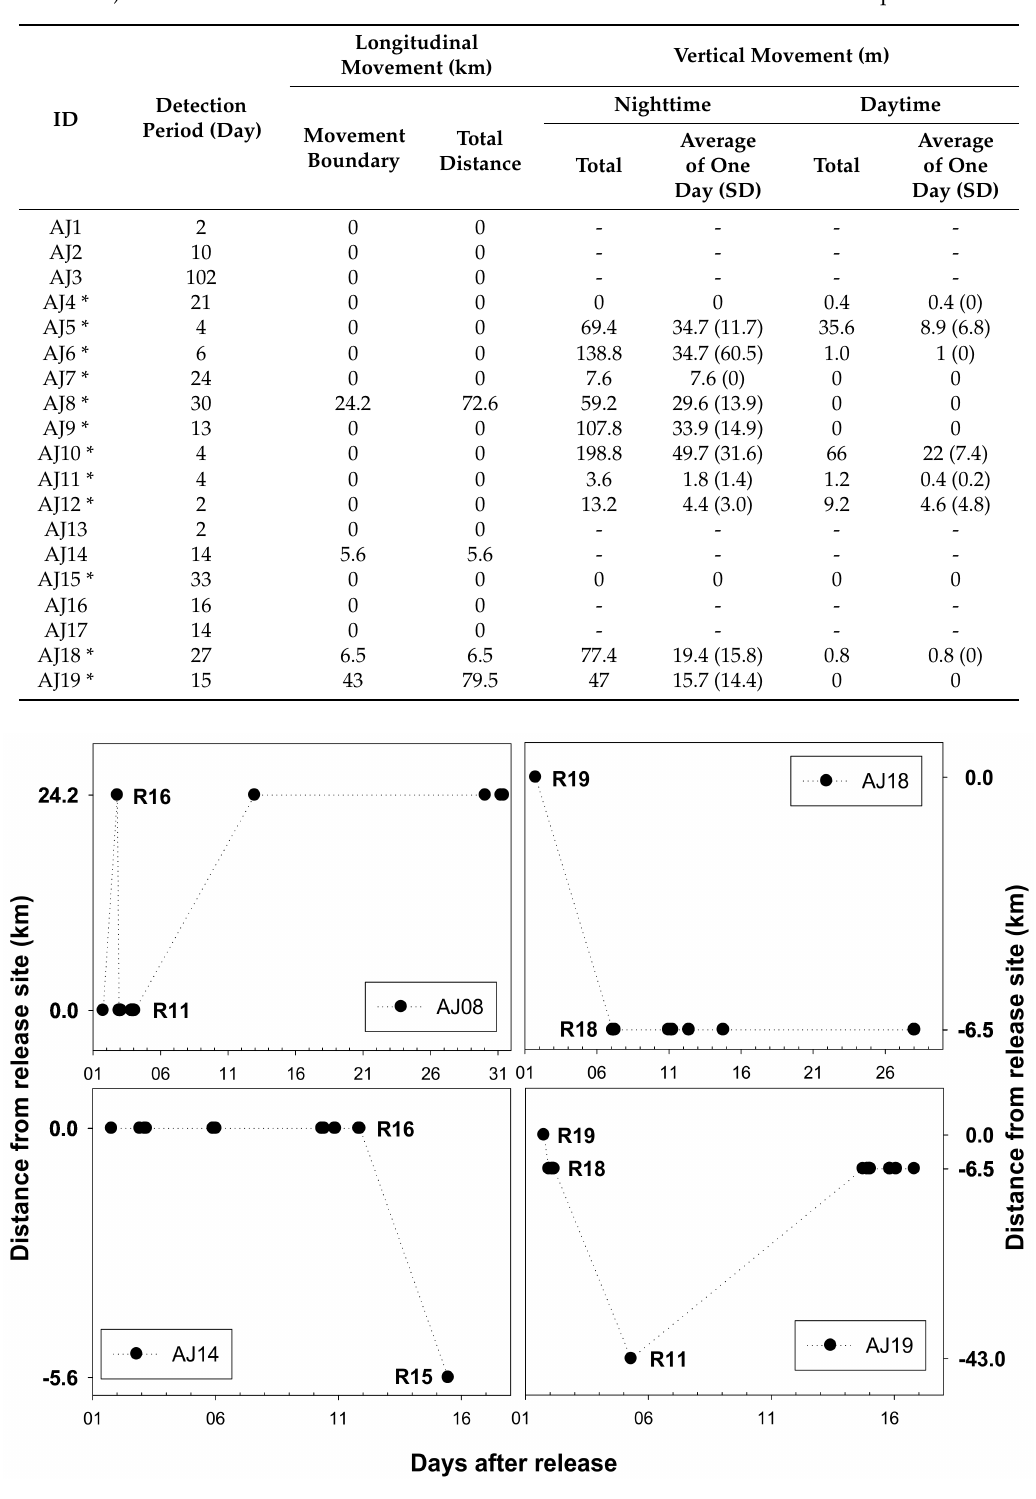
Figure 2. Migration pattern and distance of four A. japonica individuals that showed longitudinal movement. The plus value on the y -axis means movement toward an upstream direction, and the minus value means movement toward a downstream